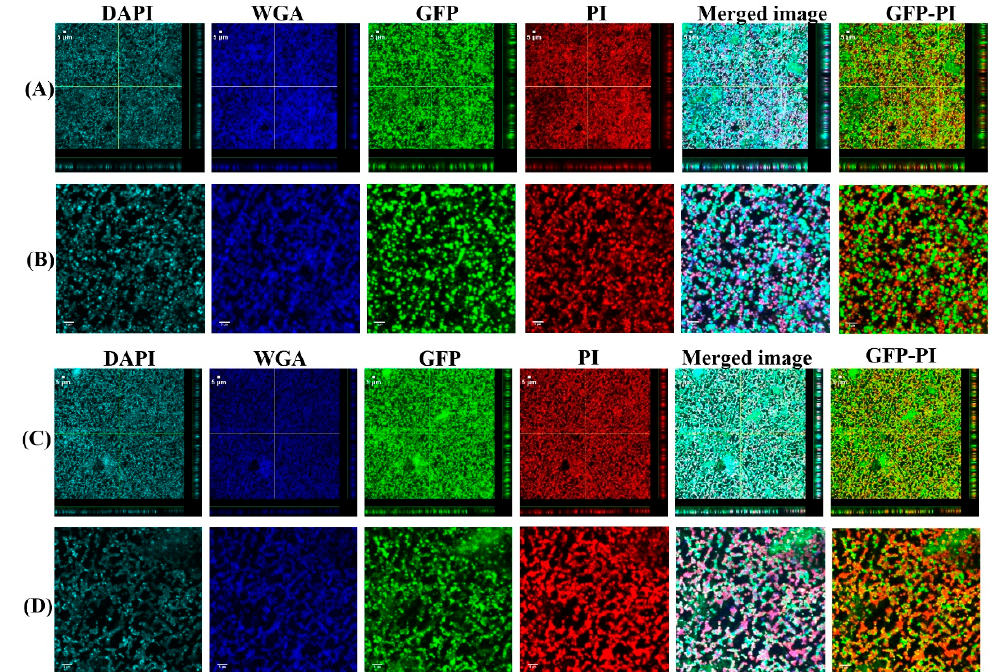
Figure 5. Confocal images of aggregated ( A , B ) and single cells ( C , D ) biofilms for 10 8 CFU/mL after 3 h antibiotic treatment. Panel B and D are zoomed images. Biofilms stained with DAPI for eDNA, WGA stain for PNAG or SF-derived HA, and PI for staining dead cells. Merged images denote the combination of DAPI, WGA, GFP, and PI images. GFP-PI is combi- nation of GFP and PI images.